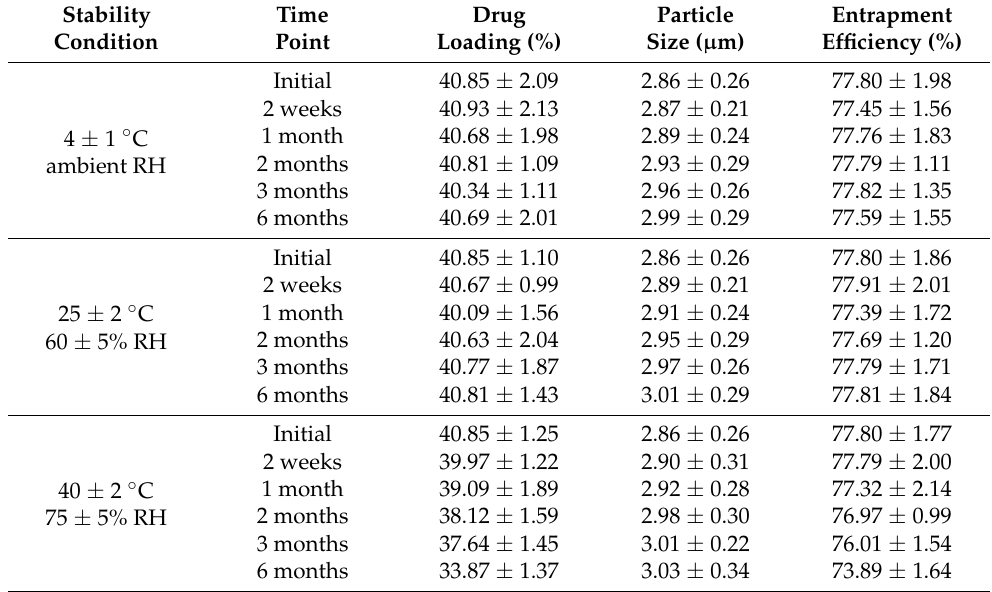
Table 4. Stability study of LVX-loaded microspheres upon long-term storage at different storage conditions. Stability